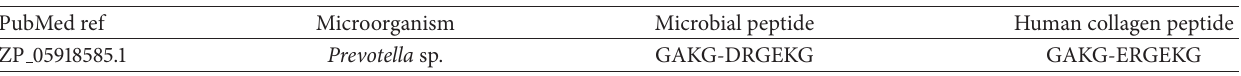
PubMed ref Microorganism Microbial peptide Human collagen peptide